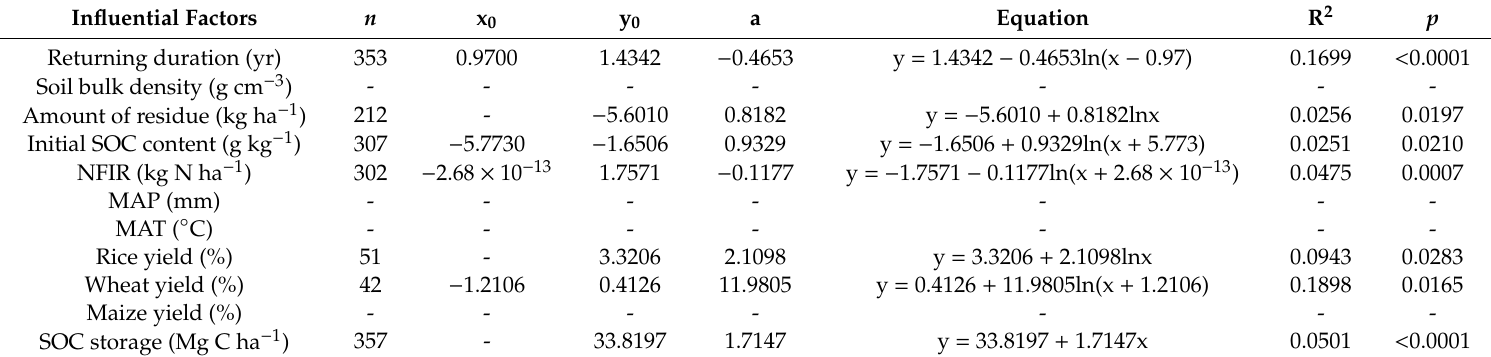
Table 3. Relationship between SOC sequestration rate and influential factors under RR in China’s